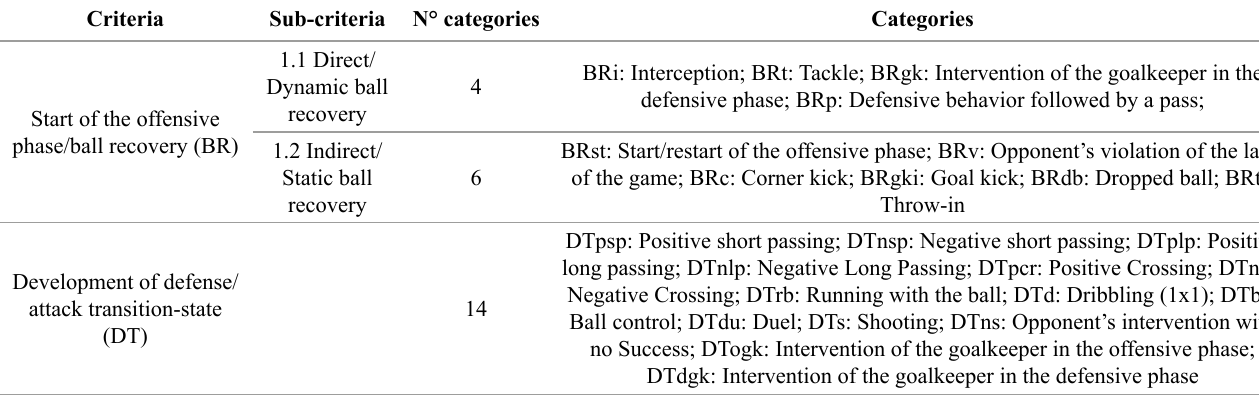
Table 2: SoccerEye Observation Instrument 25